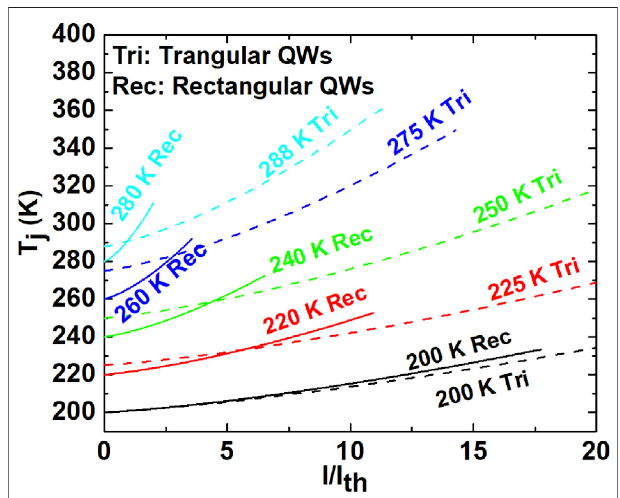
FIGURE 6 | The junction temperature T j versus injection current for the two 8- μ m ridge lasers in the two groups at different heat sink temperatures T s from 200 to 300 K. The dash and solid lines represent T j of the triangular and the rectangular QWs,